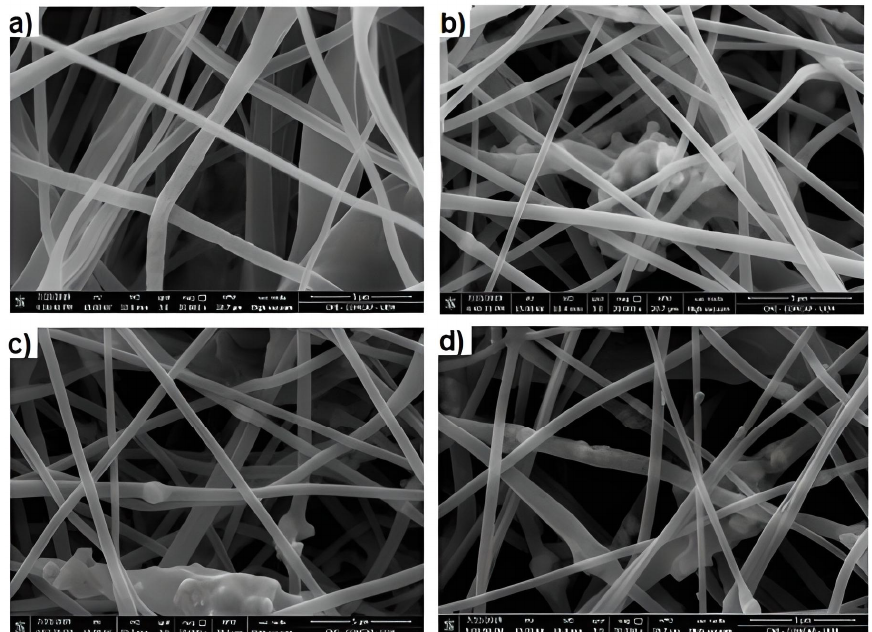
Figure 3. Scanning Electron Microscopy (SEM) images of ( a ) pure PBAT/PLA polymeric fibers; ( b ) with 10% TiO 2 -R + 1% Fe 3 O 4 ; ( c ) with 10% TiO 2 -R; and ( d ) with 1% Fe 3 O 4 . All at 20,000 × magnification.